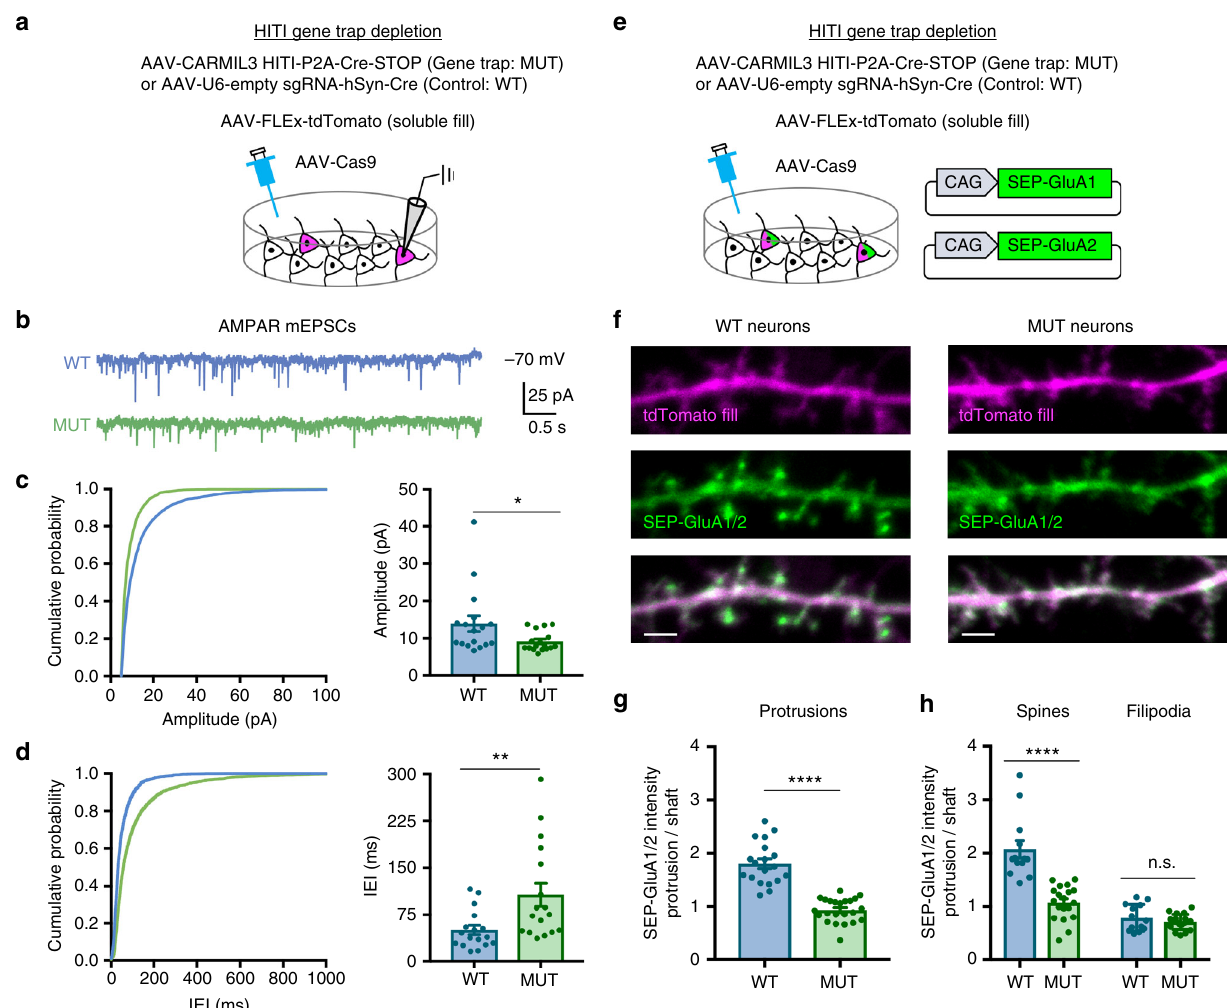
Fig. 6 CARMIL3 depletion results in functionally immature excitatory synapses. a Schematic of HITI gene trap method used to sparsely deplete CARMIL3 from cultured hippocampal neurons. Whole-cell patch clamp recordings were conducted from tdTomato-expressing cells on DIV12 – 16. b Representative traces of pharmacologically isolated AMPAR-mediated mEPSCs recorded from control (WT, blue) and CARMIL3-depleted (MUT, green) neurons. c Amplitude cumulative probability plots for AMPAR-mEPSCs. Quanti fi cation on the right shows average AMPAR-mEPSC amplitude for WT (13.92 ± 2.13 pA, n = 17 neurons) and MUT (9.16 ± 0.64 pA, n = 17 neurons) neurons. p = 0.0454. d Interevent interval (IEI) cumulative probability plots for AMPAR- mEPSCs. Quanti fi cation on the right shows average AMPAR-mEPSC IEI for WT (49.96 ± 7.50 ms, n = 17 neurons) and MUT (107.22 ± 18.62 ms, n = 17 neurons) neurons. p = 0.0095. e Schematic of method used to examine surface AMPAR levels in control and CARMIL3-depleted neurons. f Representative images of WT and MUT neurons at DIV12 – 16. tdTomato fi ll is magenta, and SEP-GluA1/2 is green. Scale bars are 2 μ m. g Graphical representation of the ratio of SEP-GluA1/2 intensity in protrusions to dendritic shafts for WT (1.81 ± 0.16, n = 19 neurons) and MUT (0.93 ± 0.05, n = 23 neurons) neurons. p < 0.0001. h Graphical representation of the ratio of SEP-GluA1/2 intensity in protrusions to dendritic shafts speci fi cally in spines (WT, 2.07 ± 0.59, n = 19 neurons; MUT, 1.07 ± 0.32, n = 23 neurons; p < 0.0001) and fi lipodia (WT, 0.79 ± 0.25, n = 19 neurons; MUT, 0.71 ± 0.14, n = 23 neurons; p = 0.319). Error bars are standard error of the mean (SEM). * p < 0.05, ** p < 0.01, **** p < 0.0001, t